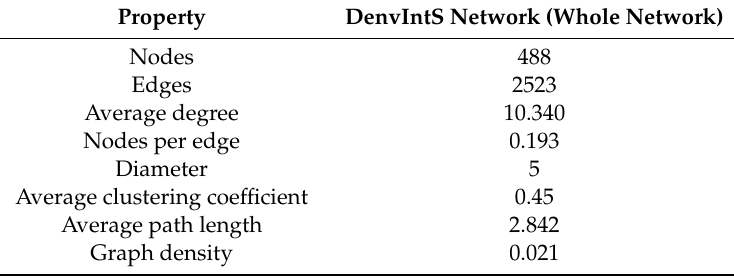
Table 3. Node properties for human protein nodes and DENV protein